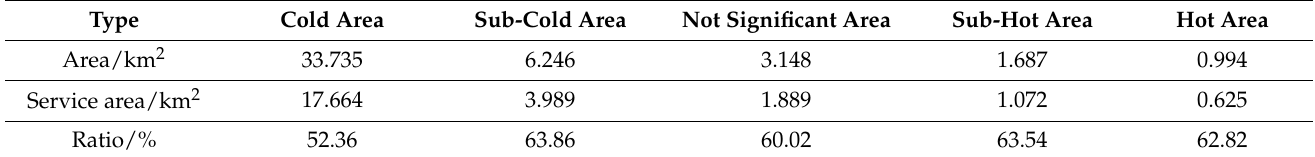
Table 4. Service space statistics of green space alleviating the heat island effect in each living heat area.